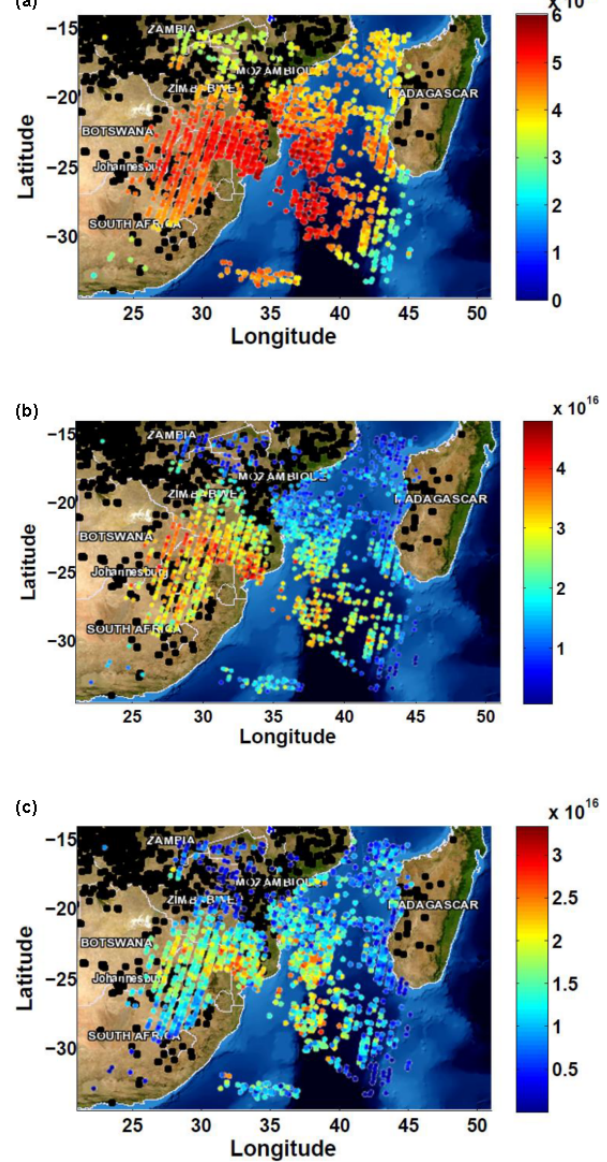
Fig. 5. Total columns of CO (a) , HCN (b) and C 2 H 2 (c) on 10 Oc- tober 2010. Fires spots detected by MODIS on 9 and 10 October are shown by the black dots.